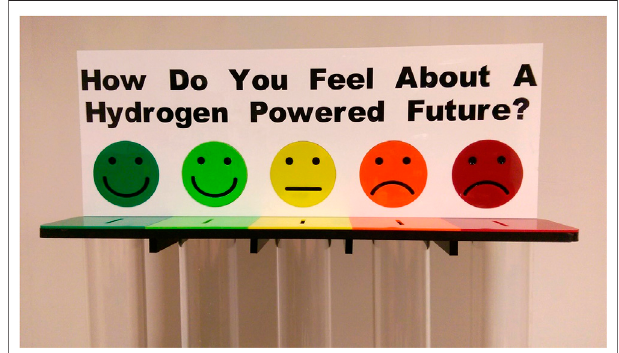
FIGURE 2 | Tokens are placed in one of fi ve tubes, labeled with different emoticons representing a participant ’ s fi nal opinion in answer to the question: “ How do you feel about a hydrogen powered future? ”